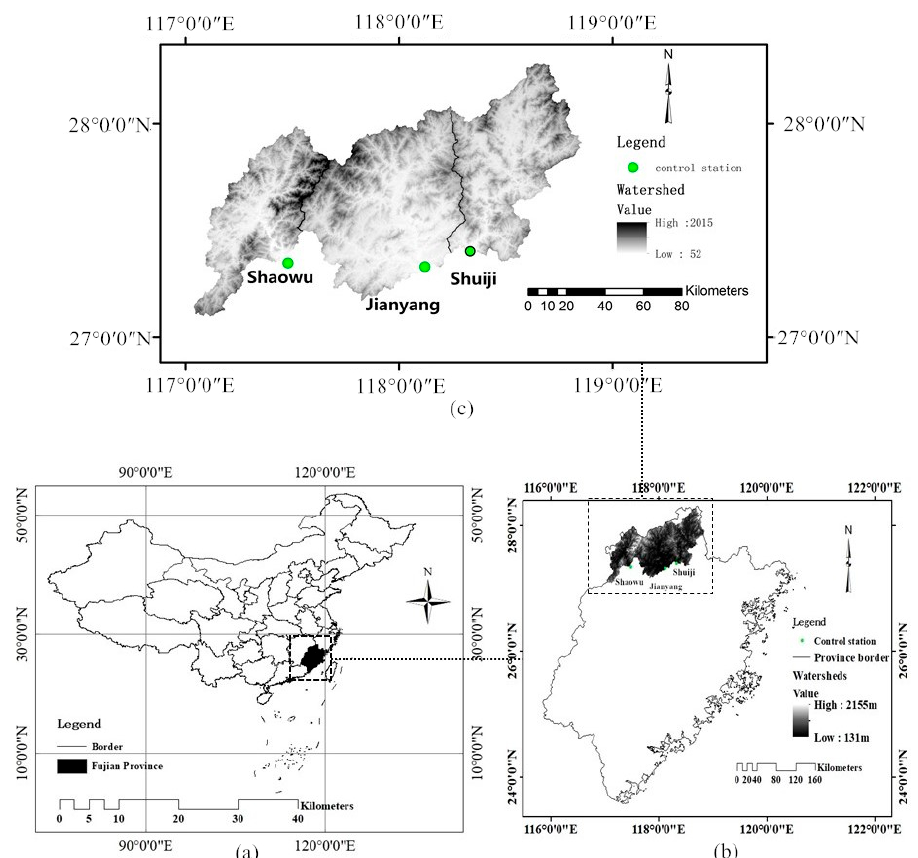
Figure 1. Location map of three watersheds selected in the study (the watershed delineation map indicates that, the selected basins (Shaowu, Jianyang, Shuiji) located in the north of Fujian Province in the southeastern of China, and elevation and terrain information of each). ( a ) location of Fujian province in China, ( b ) location of three studied watersheds in Fujian Province, ( c ) watershed digital elevation model (DEM) map of Shaowu, Jianyang, and Shuiji watersheds.